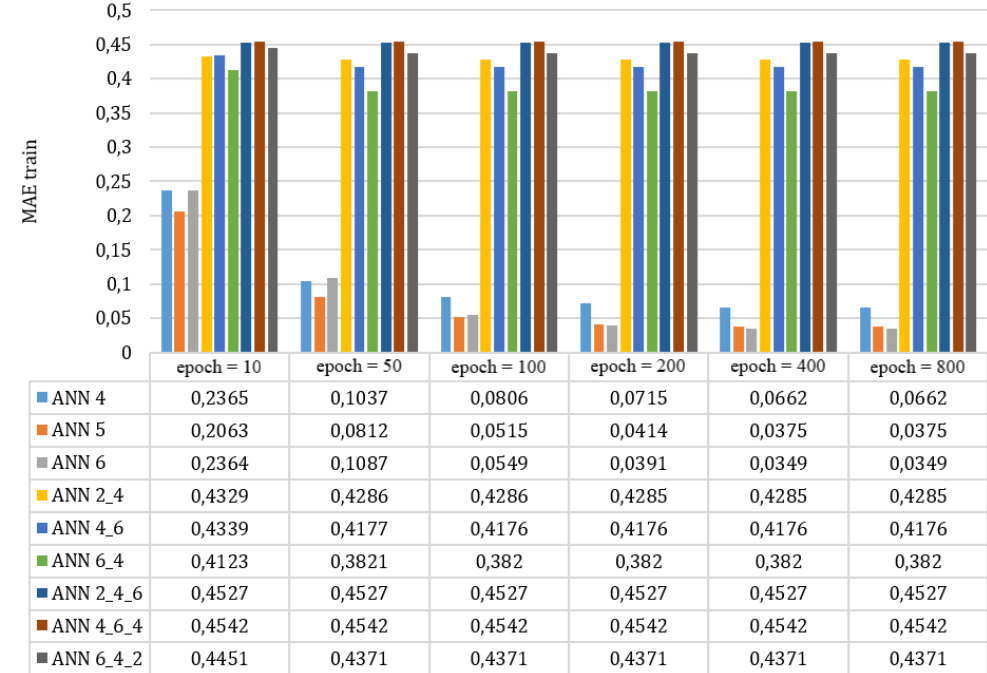
Figure 10. MAE train results of nine different ANN topologies.